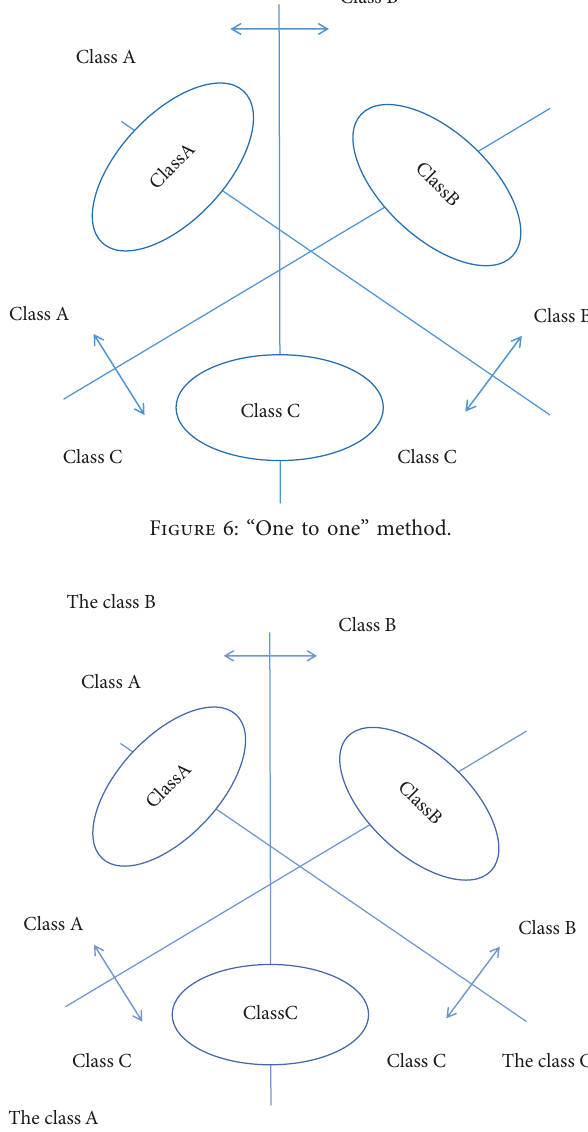
Figure 7: “One to rest” method.